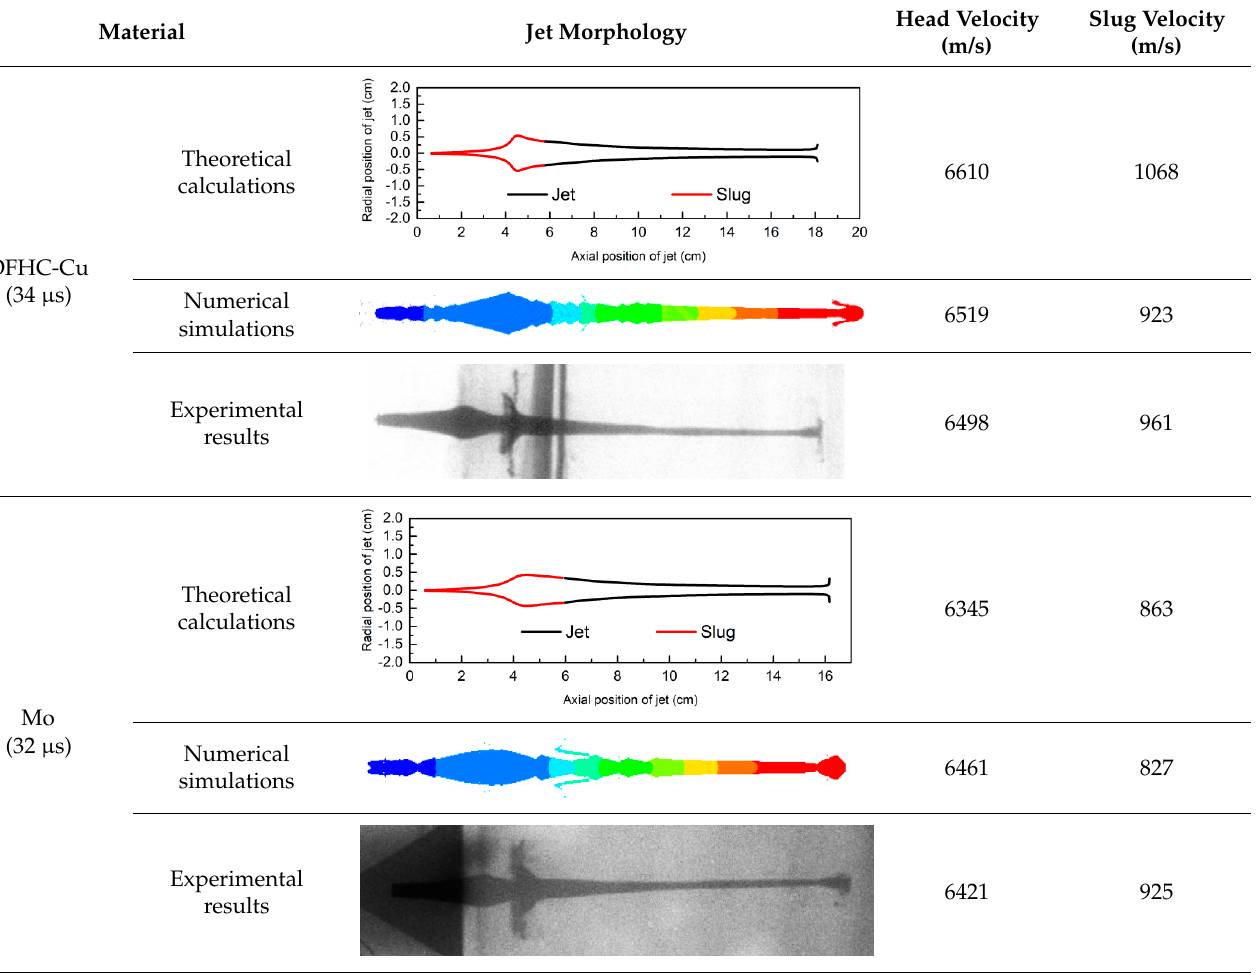
Table 2. Comparison of jet morphology.